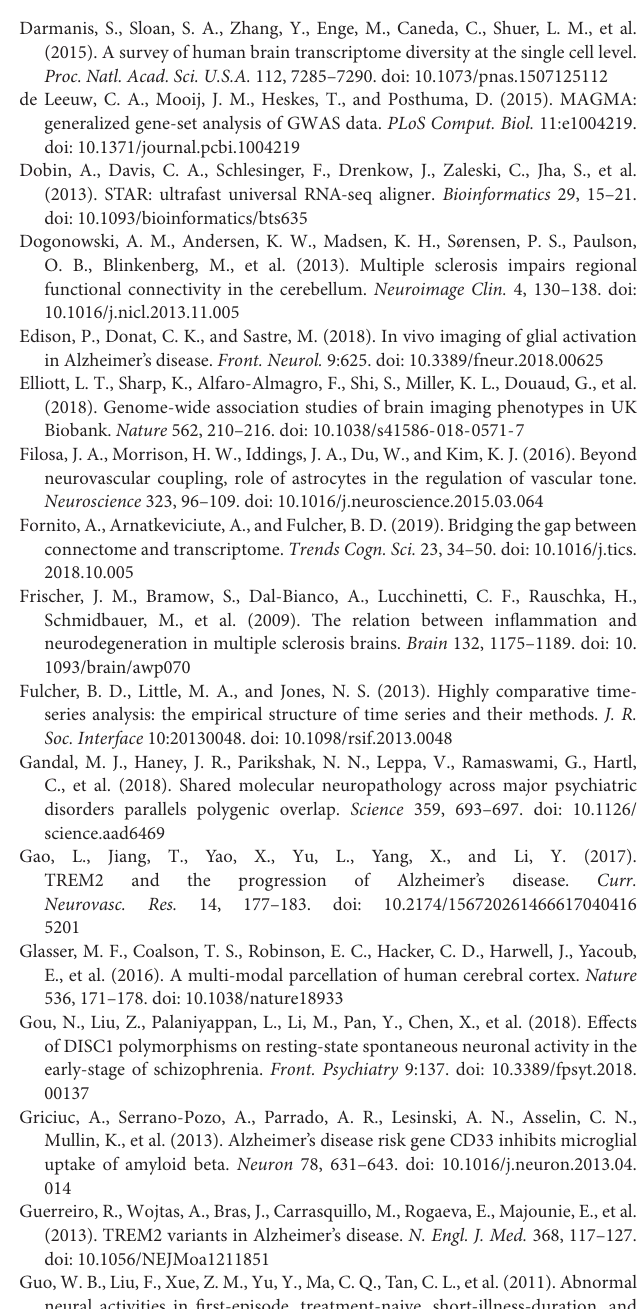
Supplementary Table 6 | The significant GO terms in ReHo-related cell-type-specific modules. BP, biological process; CC, cellular component; FDR, the corrected P values with the false discovery rate method; GO, gene ontology; MF, molecular function; ReHo, regional homogeneity. Supplementary Table 7 | The enrichment results for 10 common brain disorders in this study. The significant modules enriched for brain disorders are labeled with bold font. AD, Alzheimer’s disease; ADHD, attention deficit hyperactivity disorder; ASD, autism spectrum disorder; BP, bipolar disorder; IGAP, International Genomics of Alzheimer’s Project; ILAE, International League Against Epilepsy; IMSGC, International Multiple Sclerosis Genetics Consortium; iPSYCH, Integrative